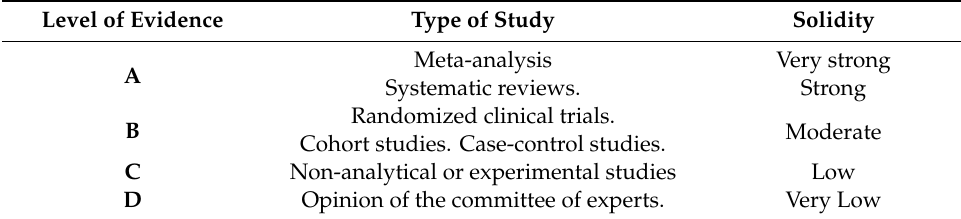
Table 1. Agreement for the stratification of the levels of evidence.